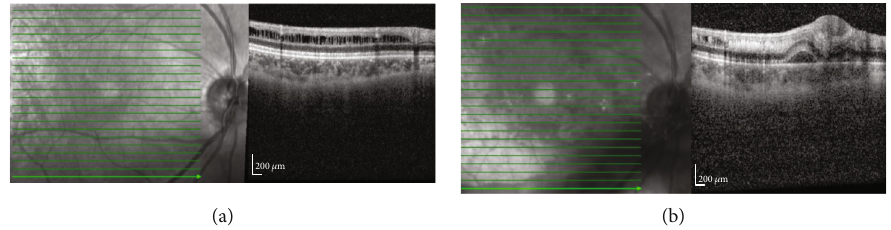
Figure 3: SD-OCT of the right eye at baseline (a; top) and after acute vitreous hemorrhage (b; bottom). (a) Retinoschisis in the inferior macula. (b) Intraretinal hemorrhage collecting within prior areas of schisis, with a focal serous neurosensory detachment.